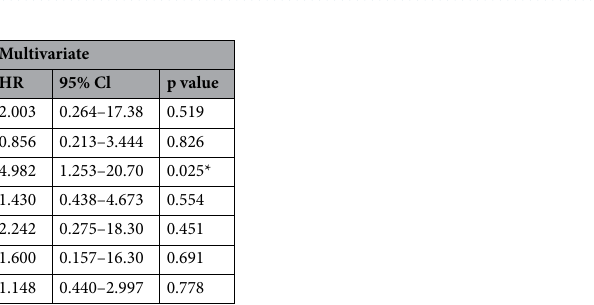
Table 5. Predictors of unfavorable outcome. † Location group as skull base/non-skull base.